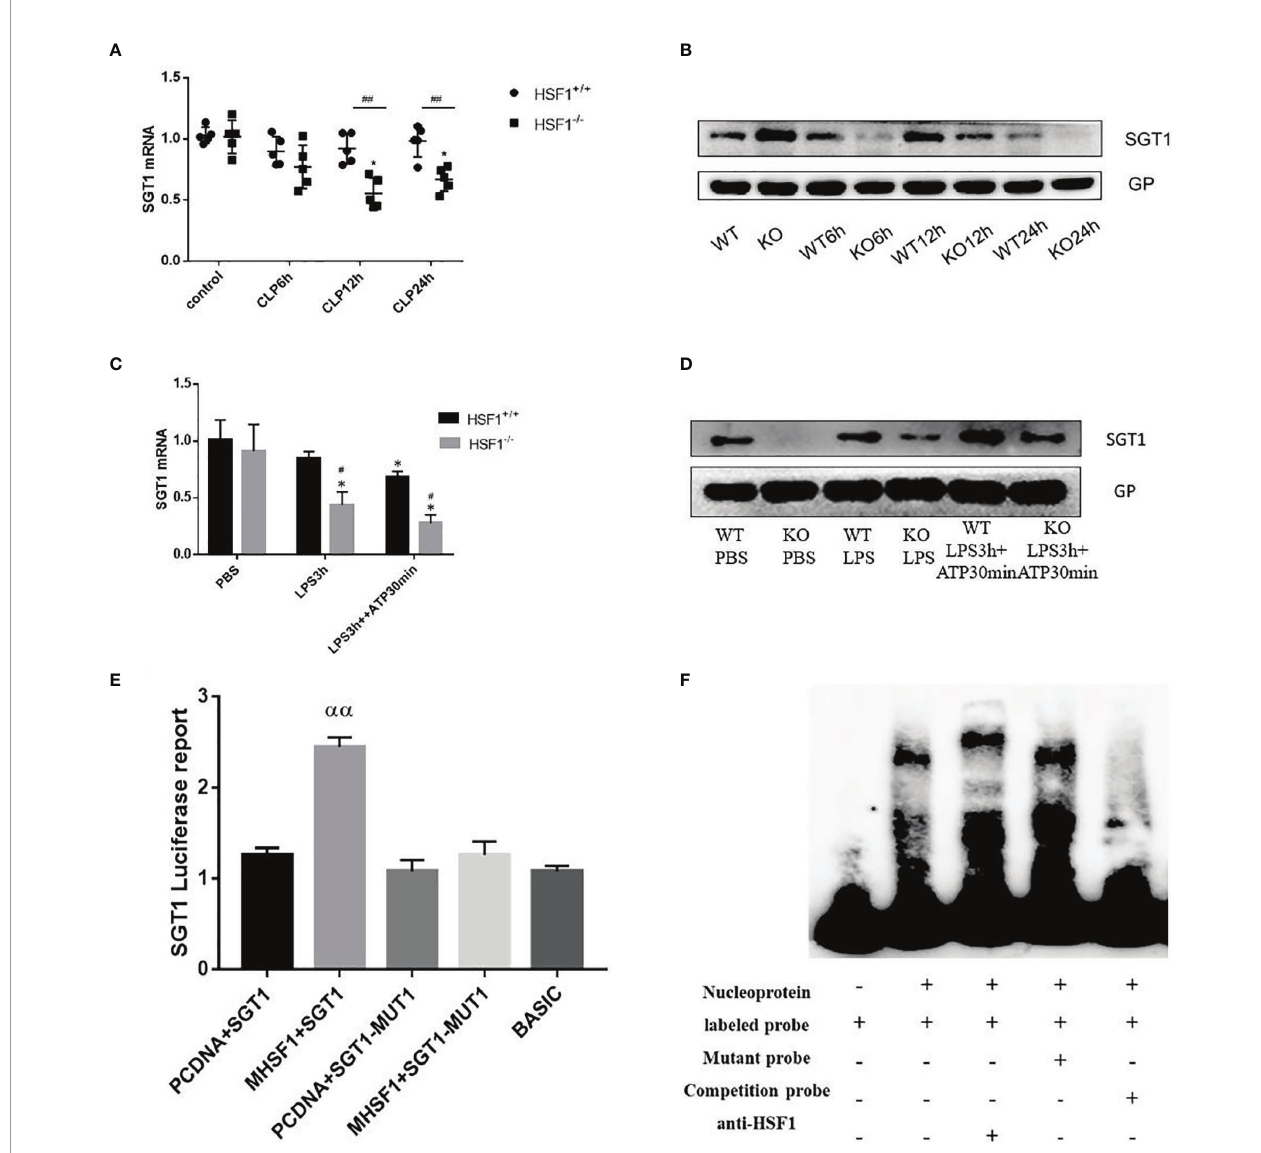
FIGURE 5 | The in fl uence of HSF1 on the transcriptional regulation of SGT1. (A, B) The expression of SGT1 in lung tissues of septic mice was detected by PCR and Western blotting. (C, D) The expression of SGT1 in primary peritoneal macrophages was detected by PCR and Western blotting. (E) The transcriptional regulation of HSF1 on SGT1 was detected by dual-luciferase reporter genes. (F) The combination of HSF1 and SGT1 was detected by EMSA. Data are representative or means (SD) of at least three independent experiments. Statistical analyses were determined using a Student ’ s t -test and one-way ANOVA. *p < 0.05, versus control group; # p < 0.05, ## p < 0.01, versus HSF1 +/+ CLP; aa P<0.01, versus PCDNA+SGT1. EMSA, electrophoretic mobility shift assay; CLP, cecal ligation and